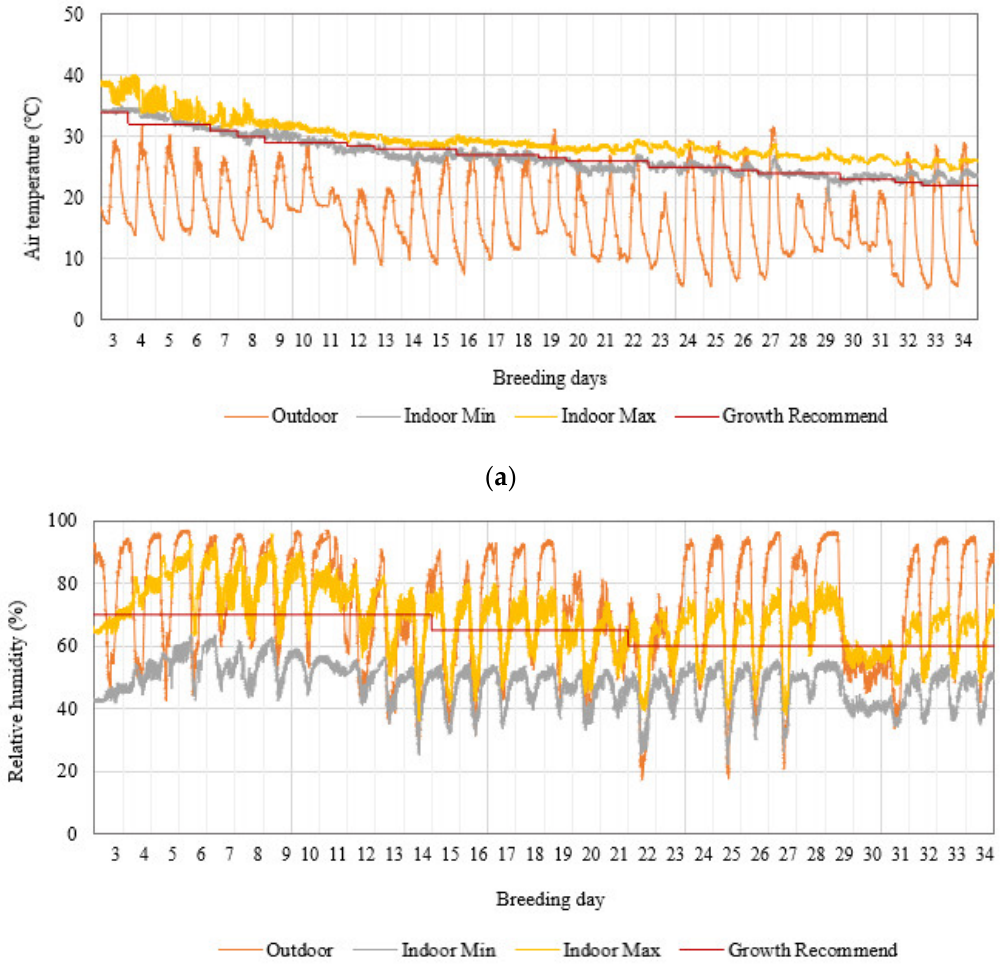
Figure 8. Measured internal environment the broiler house during the rearing period (25 September, 28 October 2020): ( a ) Measured and optimum growth of air temperature; ( b ) Measured and optimum growth of air relative humidity.